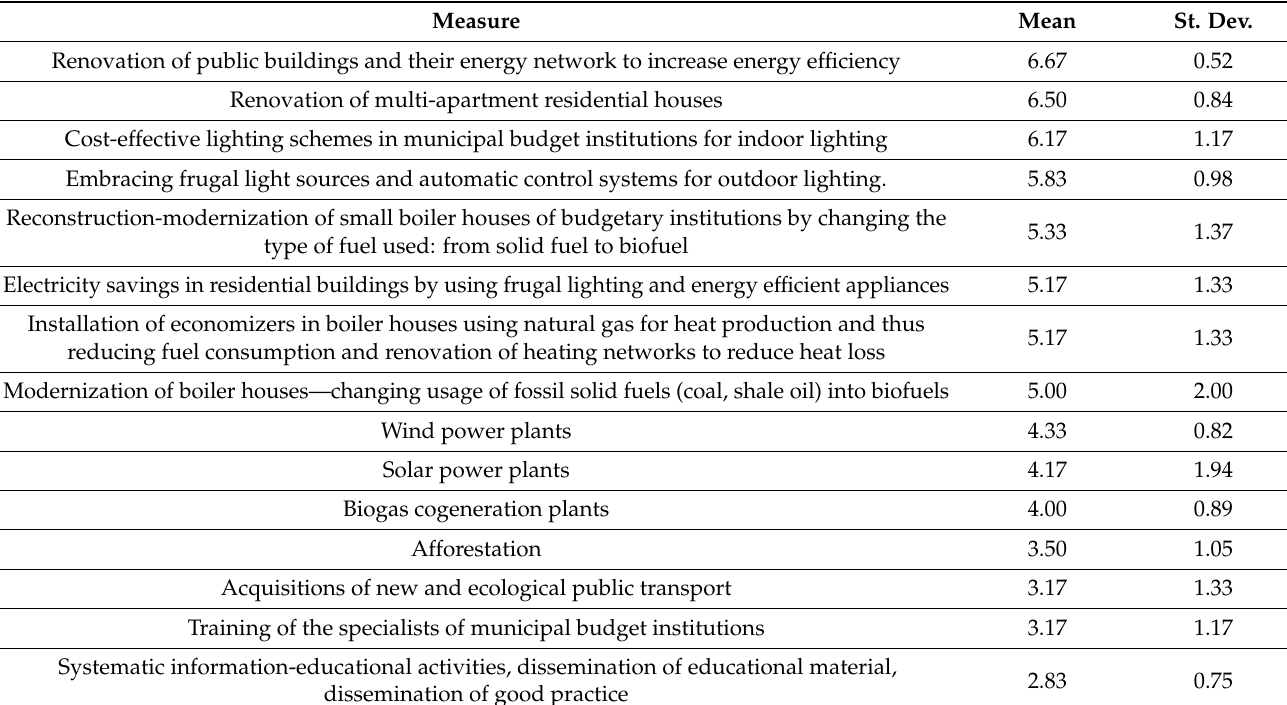
Table 6. Results of the ranking of GHG reduction